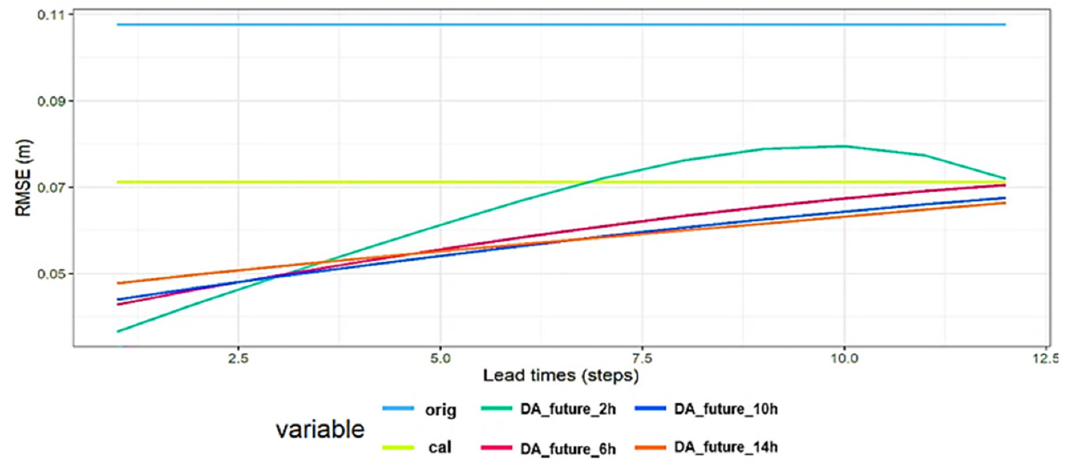
Figure 10. Performance of tidal wave prediction with varying future DA window sizes.